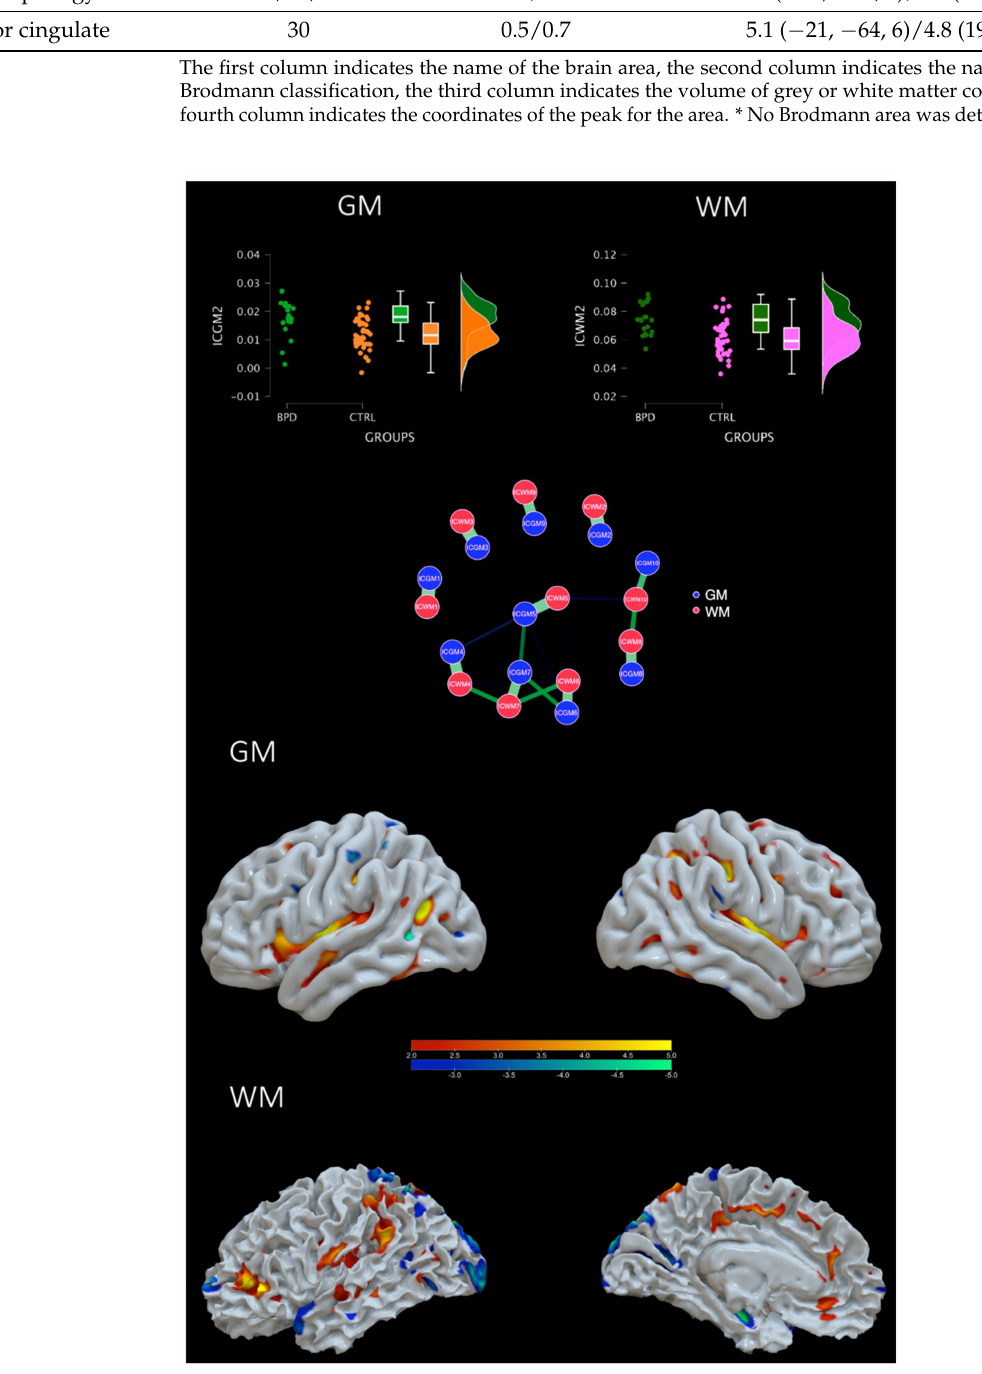
Figure 3. A covarying GM-WM network that differs from BPD and HC . Top: violin plots of the loading coefficients for GM and WM of the IC2. Central: network plot showing in green the strength of correlations between components. Bottom: brain plot of positive (increased GM-WM concentration) and negative (decreased GM-WM concentration) of